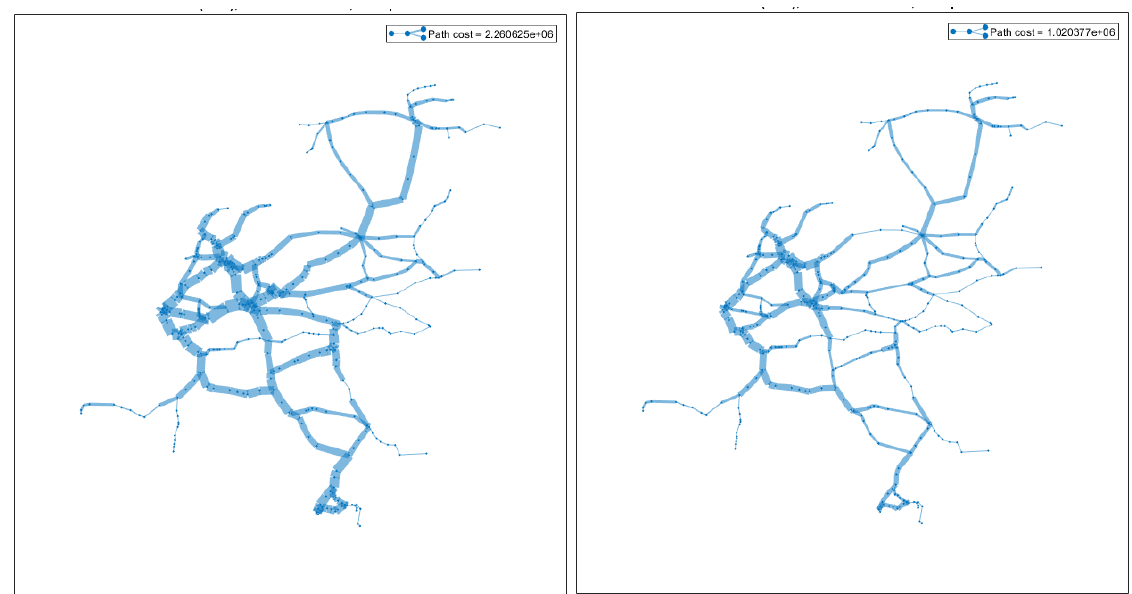
Figure 3. Passenger flows for normal and covid19 conditions with 50%